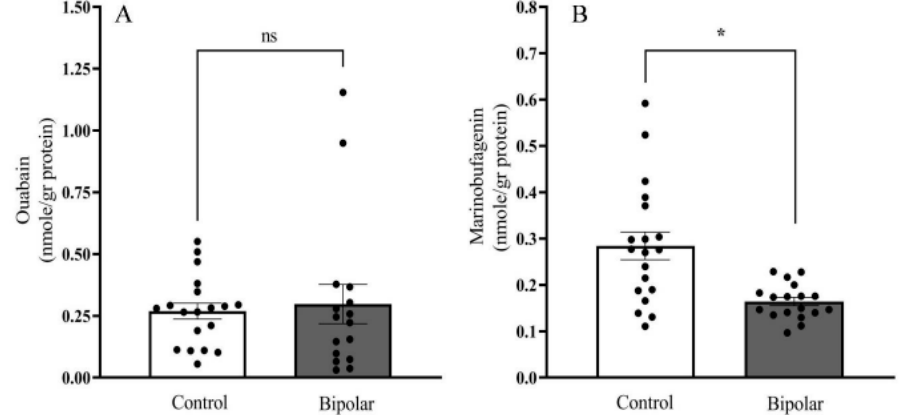
Figure 5. Endogenous OUA and MBG levels in smokers and non-smokers. OUA ( A ) and MBG ( B ) immuno-reactivity levels in the postmortem PFC of all samples assayed were determined by DELFIA, as described in the materials and methods. The bars represent the means; the error bars represent the standard error of the means. * differ from the control group p < 0.05.